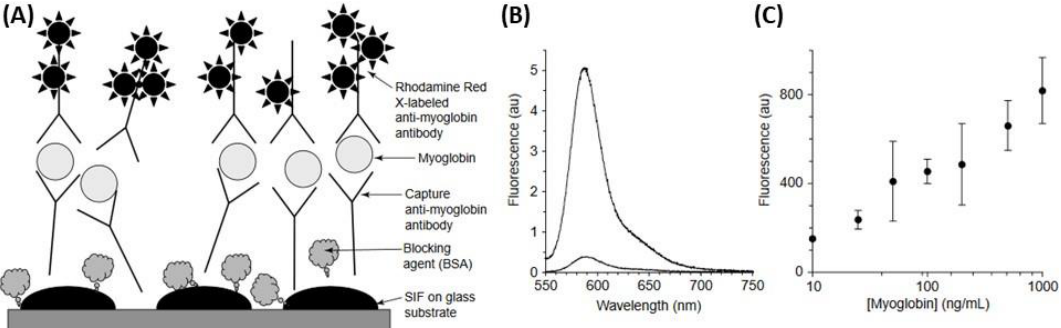
Figure 28. ( A ) Illustration of a metal-enhanced sandwich immunoassay on silver island films (SIFs). Fluorescence emission of the Rhodamine Red-X-labeled anti-myoglobin antibody attached to the surface-immobilized myoglobin ( B ) for a given myoglobin concentration (100 ng/mL) on SIFs and on glass, and ( C ) at different myoglobin concentrations on SIFs. Adapted from [191]. Copyright (2005),